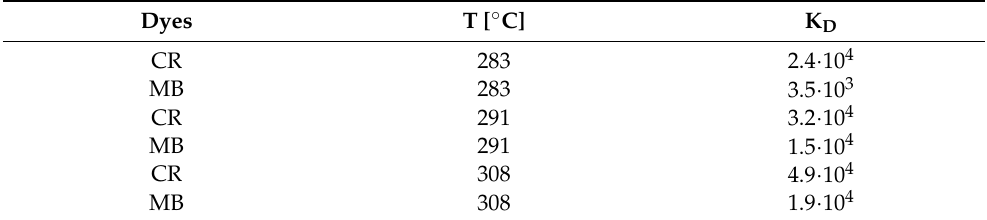
Table 2. Calculated values of K d .